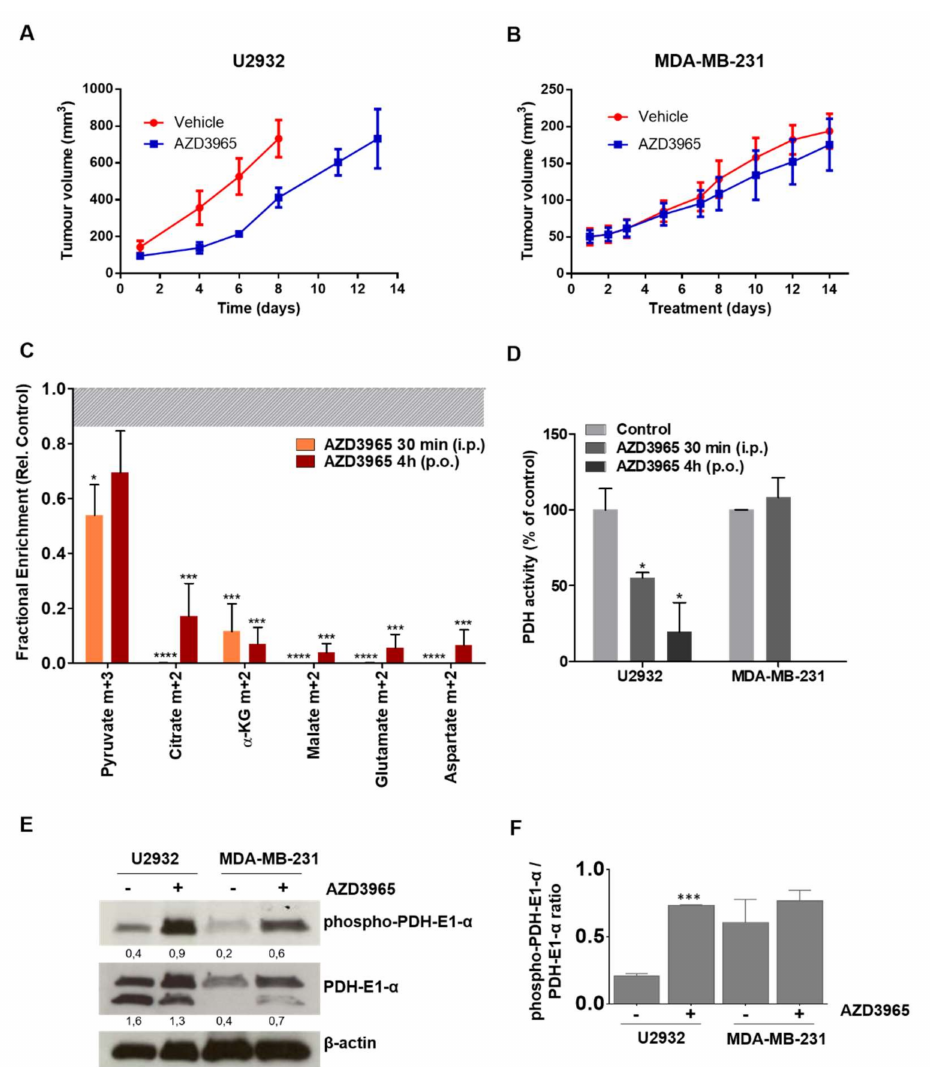
Figure 5. AZD3965 treatment inhibits tumor growth, the TCA cycle and PDH activity. ( A ) Anti-tumor activity of AZD3965 (100 mg / kg p.o. twice daily, n = 6–8) against U2932 and ( B ) MDA-MB-231 xenografts. ( C ) TCA cycle metabolite enrichment (pyruvate m + 3, citrate m + 2, α -ketoglutarate ( α -KG) m + 2, malate m + 2, glutamate m + 2, aspartate m + 2) in U2932-tumor-bearing mice infused with D-[ 13 C 6 ]glucose following treatment with AZD3965 (100 mg / kg) for 30 min (i.p.) or 4 h (p.o.). Data are expressed as fractional enrichment relative to control (vehicle), indicated by the dotted line (average) and shaded bar (SEM). ( D ) Analysis of PDH activity by Enzyme-Linked Immunosorbent Assay (ELISA) in U2932 and MDA-MB-231 tumors excised from mice treated with AZD3965 (100 mg / kg) or vehicle (control) for 30 min or 4 h. ( E ) Representative blots and ( F ) respective quantification ( n = 3) of the expression of phospho-PDHE1- α and PDHE1- α in tumors excised from U2932 and MDA-MB-231-tumor bearing mice treated with AZD3965 (100 mg / kg) or vehicle (control) for 4 h; values represent ratio of protein to β -actin, which was used as loading control; uncropped blots are shown in Figure S8. All data are average ± SEM ( n = 4–6). * p ≤ 0.05, *** p ≤ 0.005 and **** p ≤